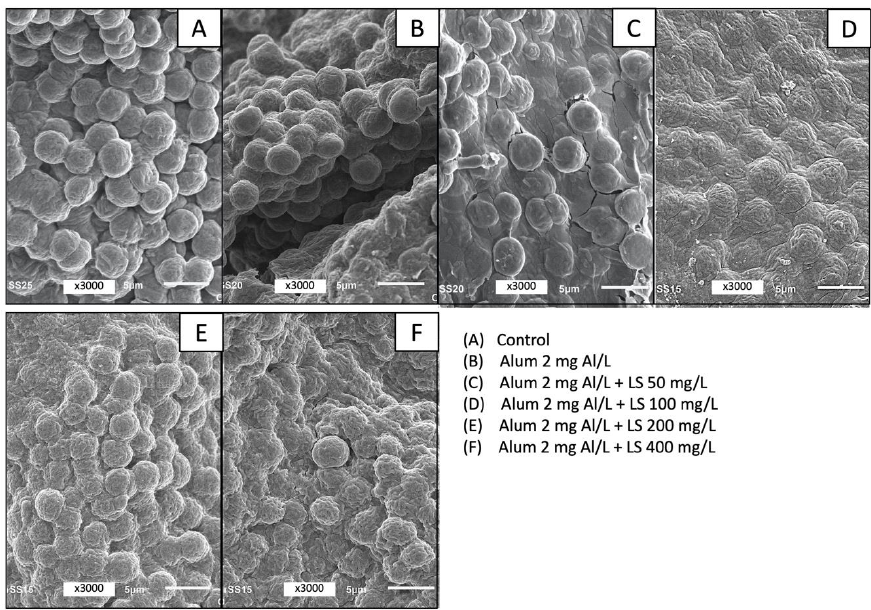
Figure 7. Scanning electron microscope images of Microcystis aeruginosa at 3000 × magnification following addition of LS ballast at ( A ) 0 mg/L, ( B ) 50 mg/L, ( C ) 100 mg/L, ( D ) 200 mg/L, and ( E ) 400 mg/L.